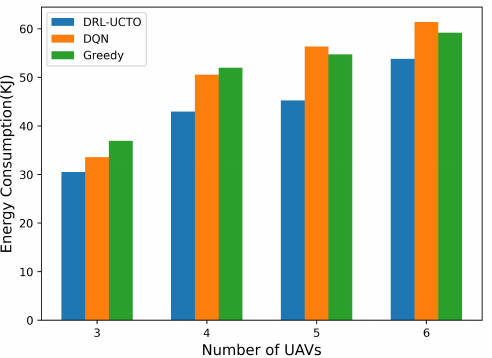
Figure 7. Impact of deploying different numbers of UAVs on system energy